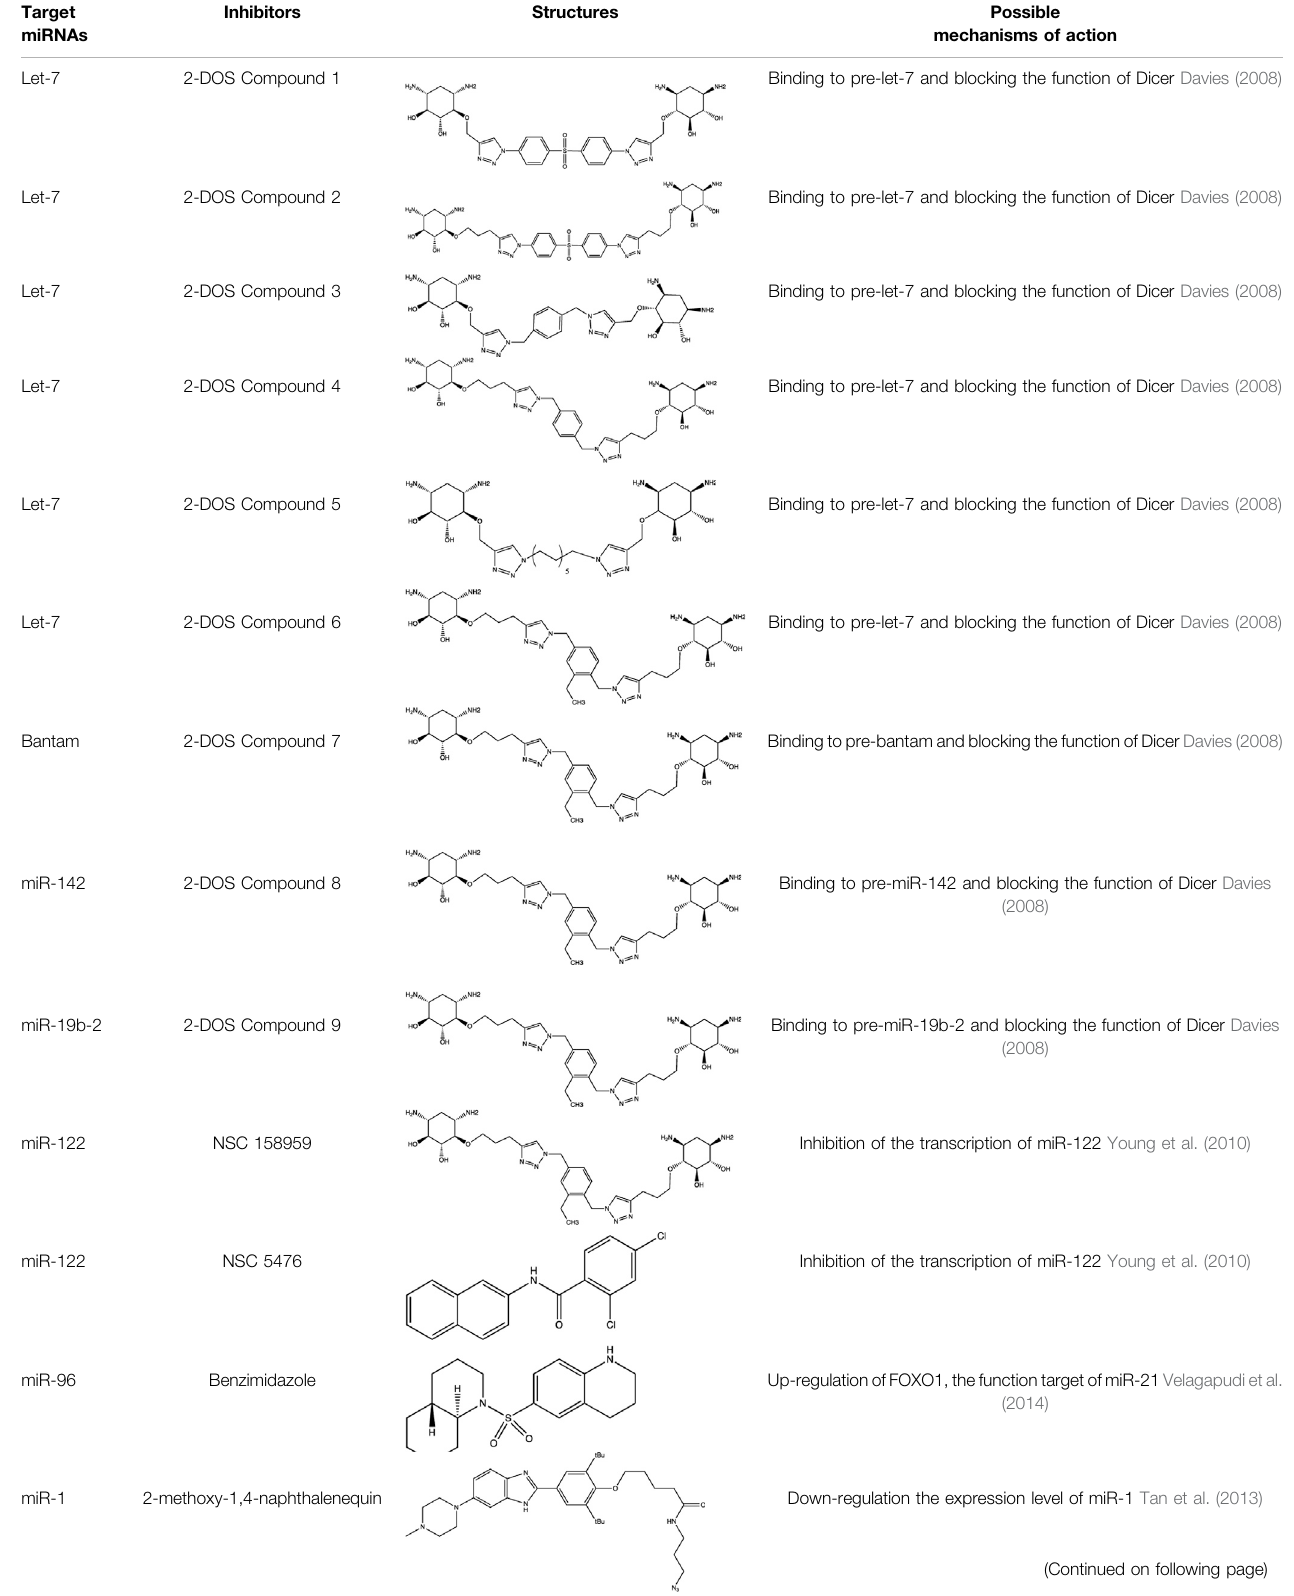
TABLE 4 | ( Continued ) The summary of some representative small-molecule miRNA